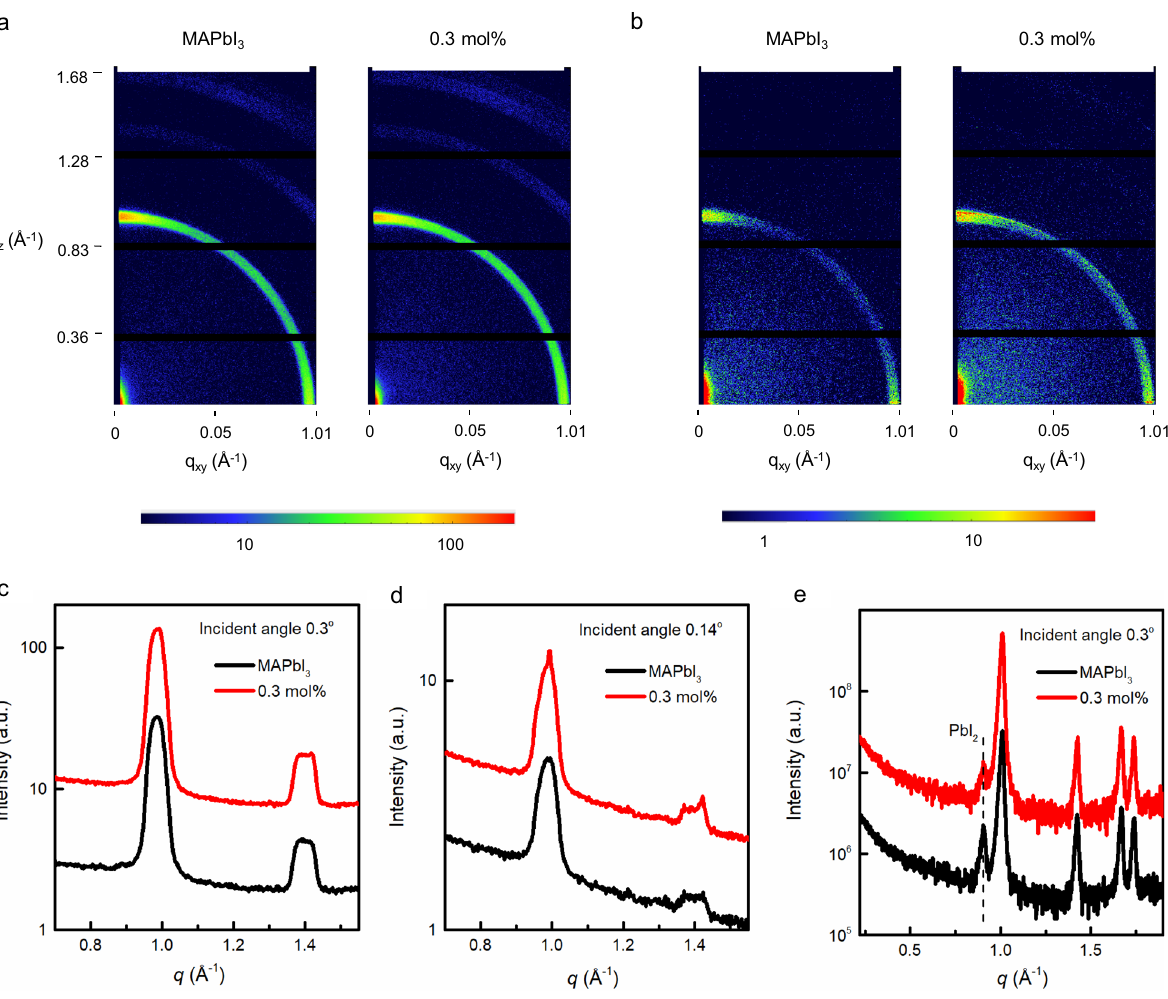
Fig. 4 2D GI-WAXS measurements and out-of-plane, high-resolution GI-XRD patterns of the thin fi lms. The 2D GI-WAXS measurements with an incident beam of a 0.3° and b 0.14° for the neat MAPbI 3 and 0.3 mol% (FEA) 2 PbI 4 -containing fi lms. Azimuthally averaged GI-WAXS pro fi les of the neat MAPbI 3 and 0.3 mol% (FEA) 2 PbI 4 -containing fi lms collected at an incidence angle of c 0.3° and d 0.14°. e Out-of-plane, high-resolution GI-XRD patterns of thin fi lms collected at an incidence angle of 0.3° (note the data have been offset for clarity). q = momentum transfer, q z and q xy = the components of the scattering vector ( q ) in the direction of the surface normal ( z ) and transverse to it ( xy